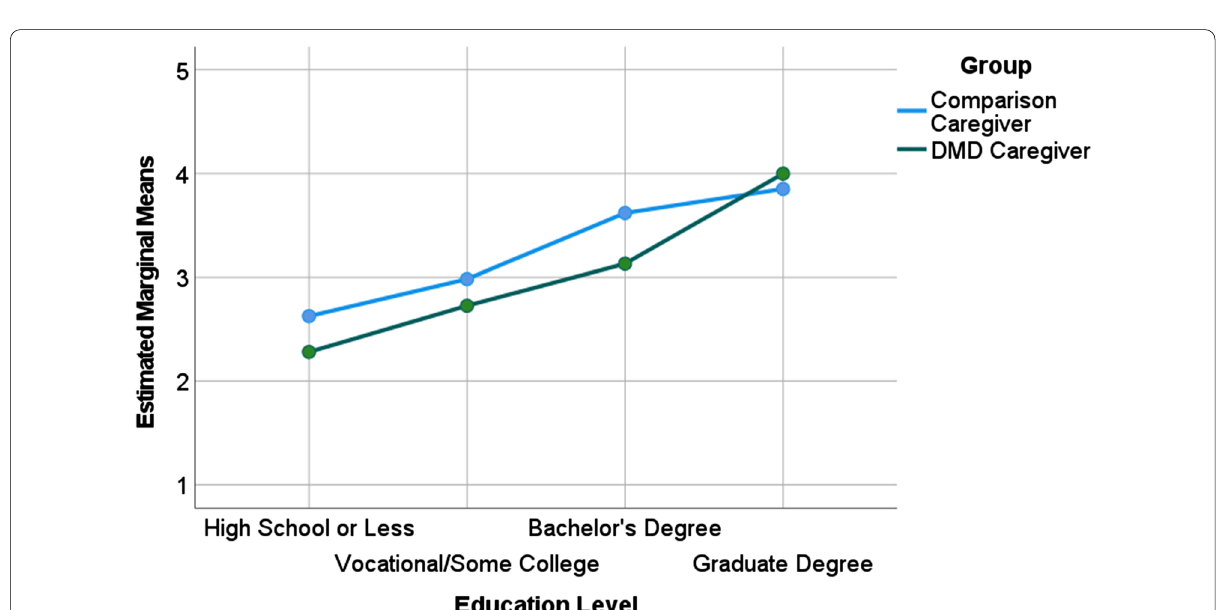
Fig. 3 Occupational Complexity achieved by DMD versus comparison caregivers. DMD caregivers showed lower levels of occupational complexity after adjusting for education, across all levels with the exception of graduate-level